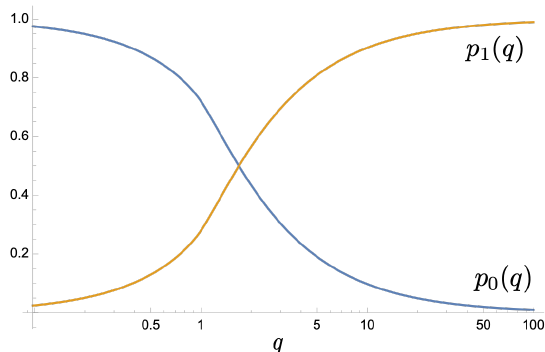
Figure 13 . The plot showing the trend of p i ( q ) . We have taken m = 1